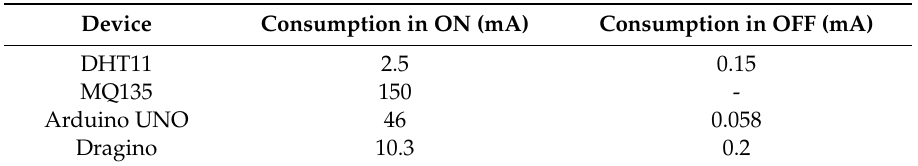
Table 4. Consumption for each device.